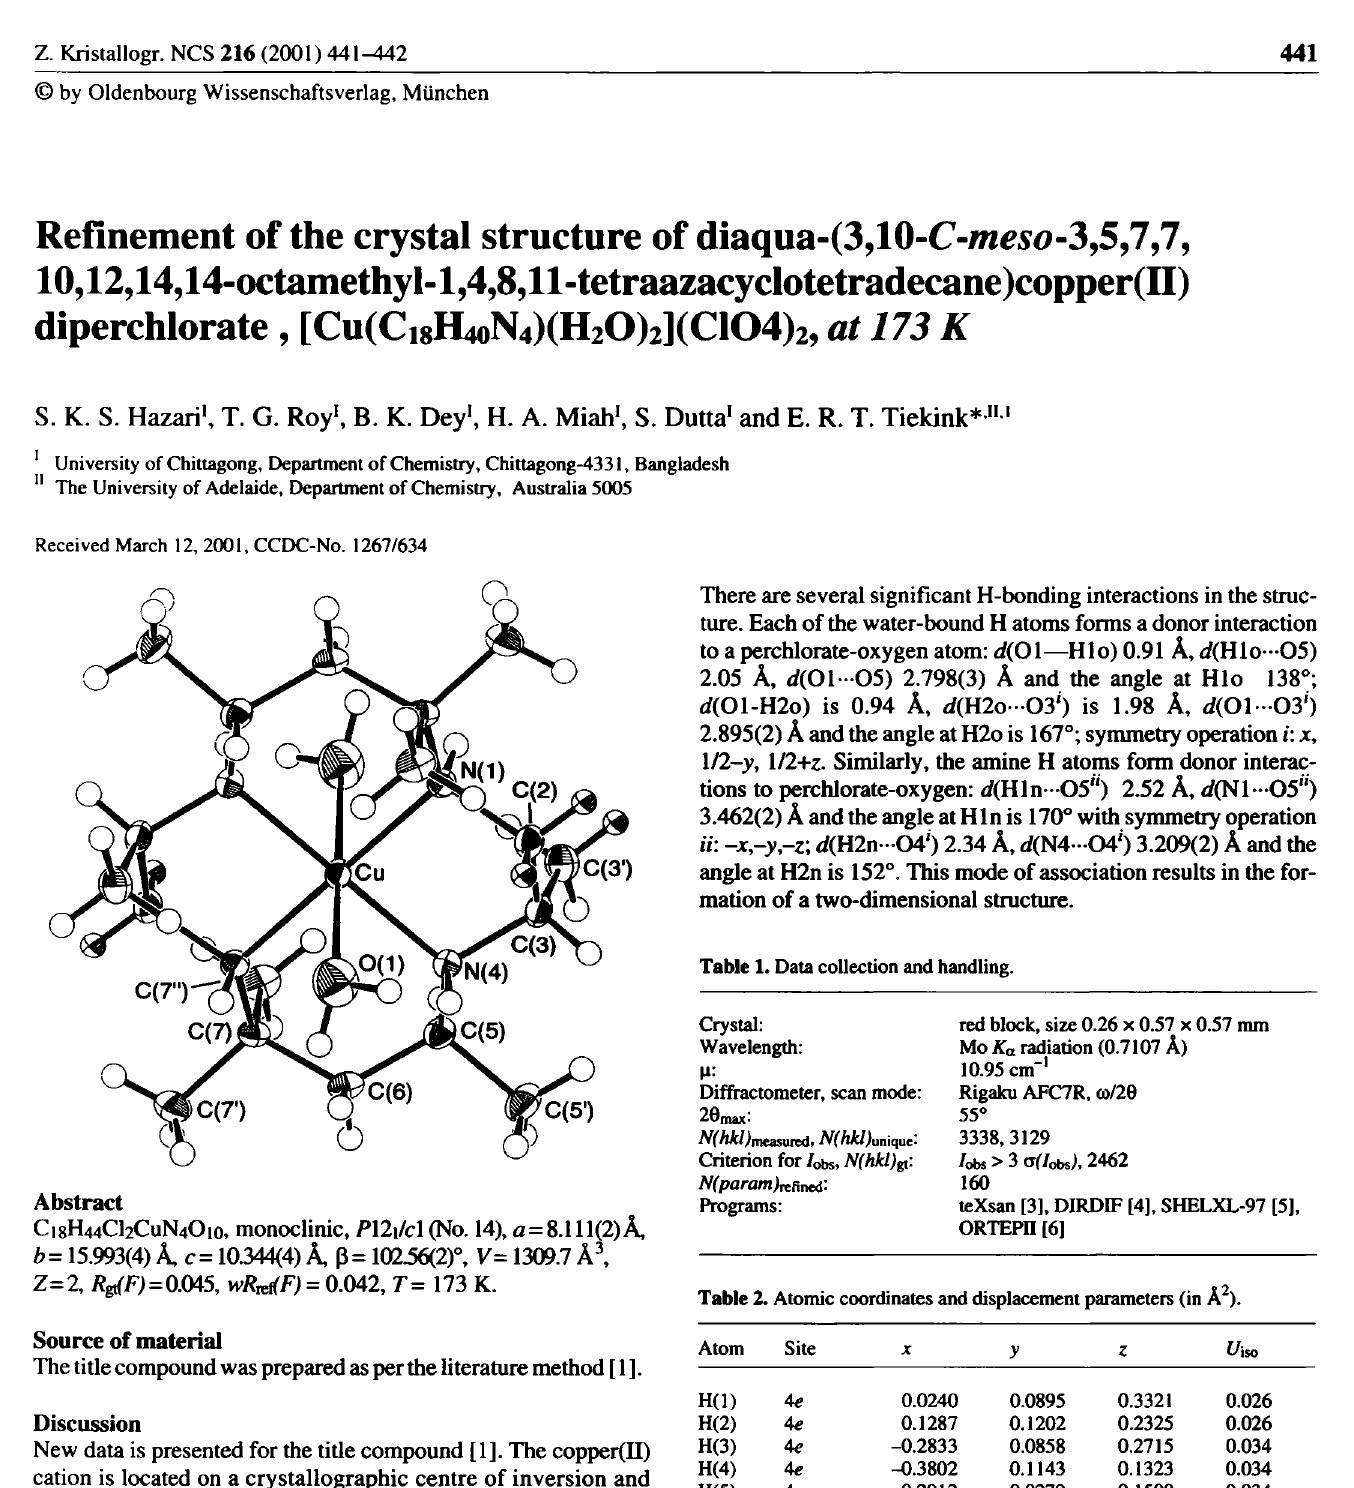
Table 2. Atomic coordinates and displacement parameters (in Ä 2